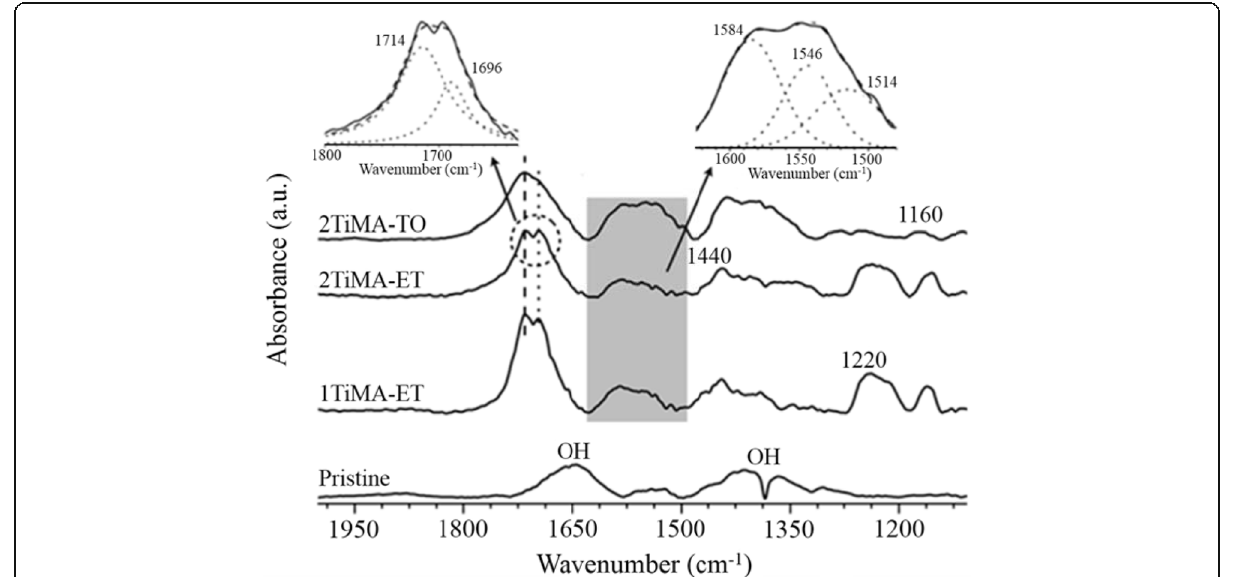
Fig. 5 FTIR spectra of TiO 2 , 1TiMA-ET, 2TiMA-ET, and 2TiMA-TO in the range from 2000 to 1100 cm -1